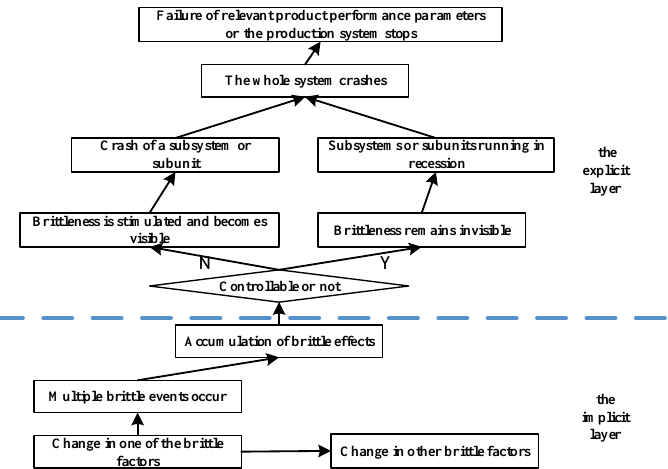
Figure 1. Analysis of the process whereby manufacturing system brittleness is stimulated until a collapse collapse occurs.